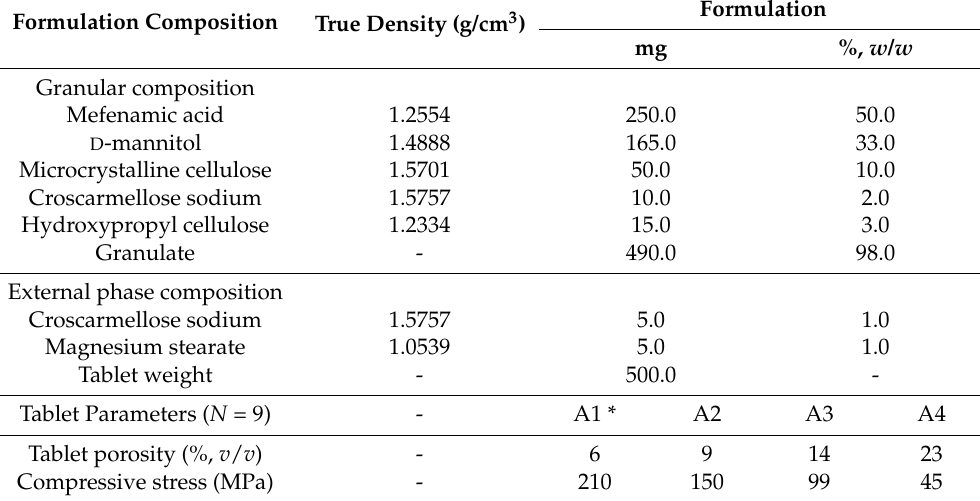
Table 1. An 11.28-mm round flat-faced punch set was used for the preparation of the formulation. Table 1. Formulation compositions and tablet compaction parameters